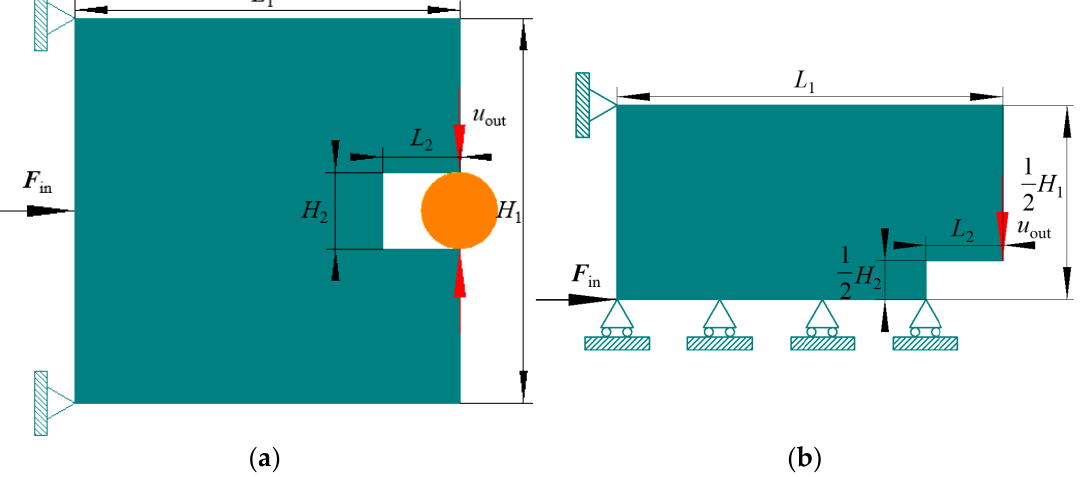
Figure 9. Original design domain for CGM: ( a ) whole design domain; ( b ) upper half part.